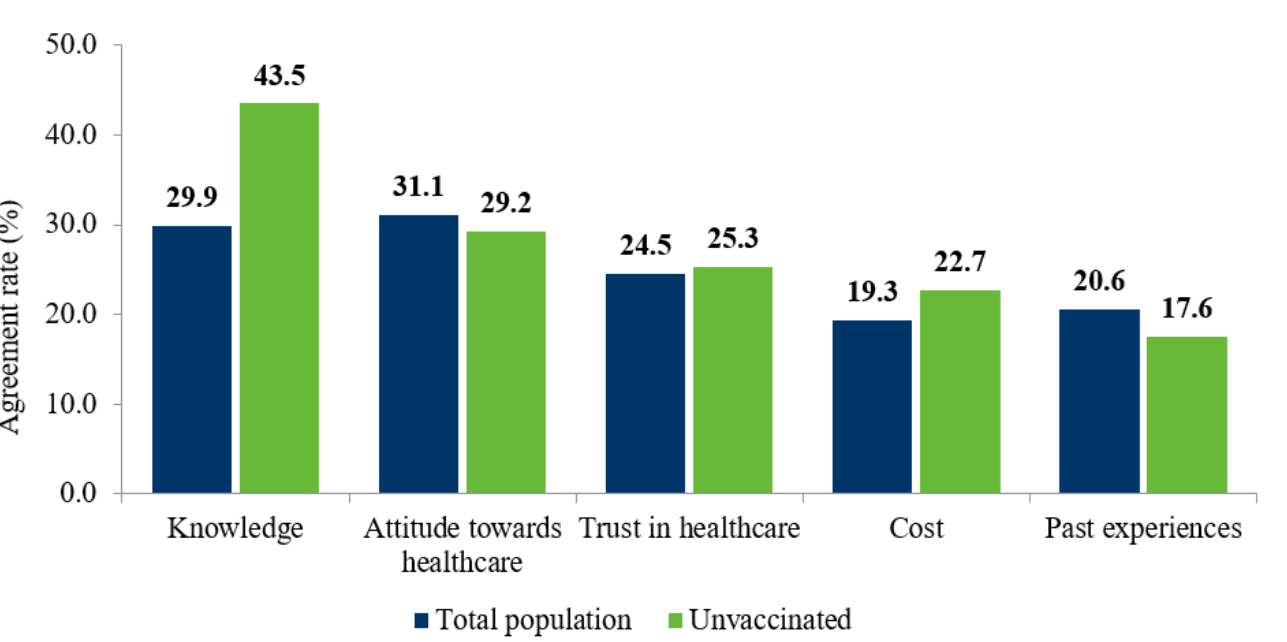
Figure 3. Question types as barriers to vaccination: total versus unvaccinated population.